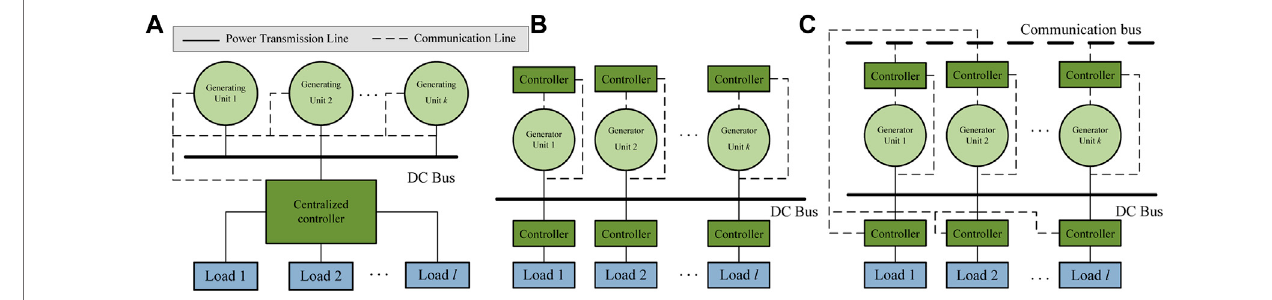
FIGURE 9 | Three schematic diagram of coordinated control.